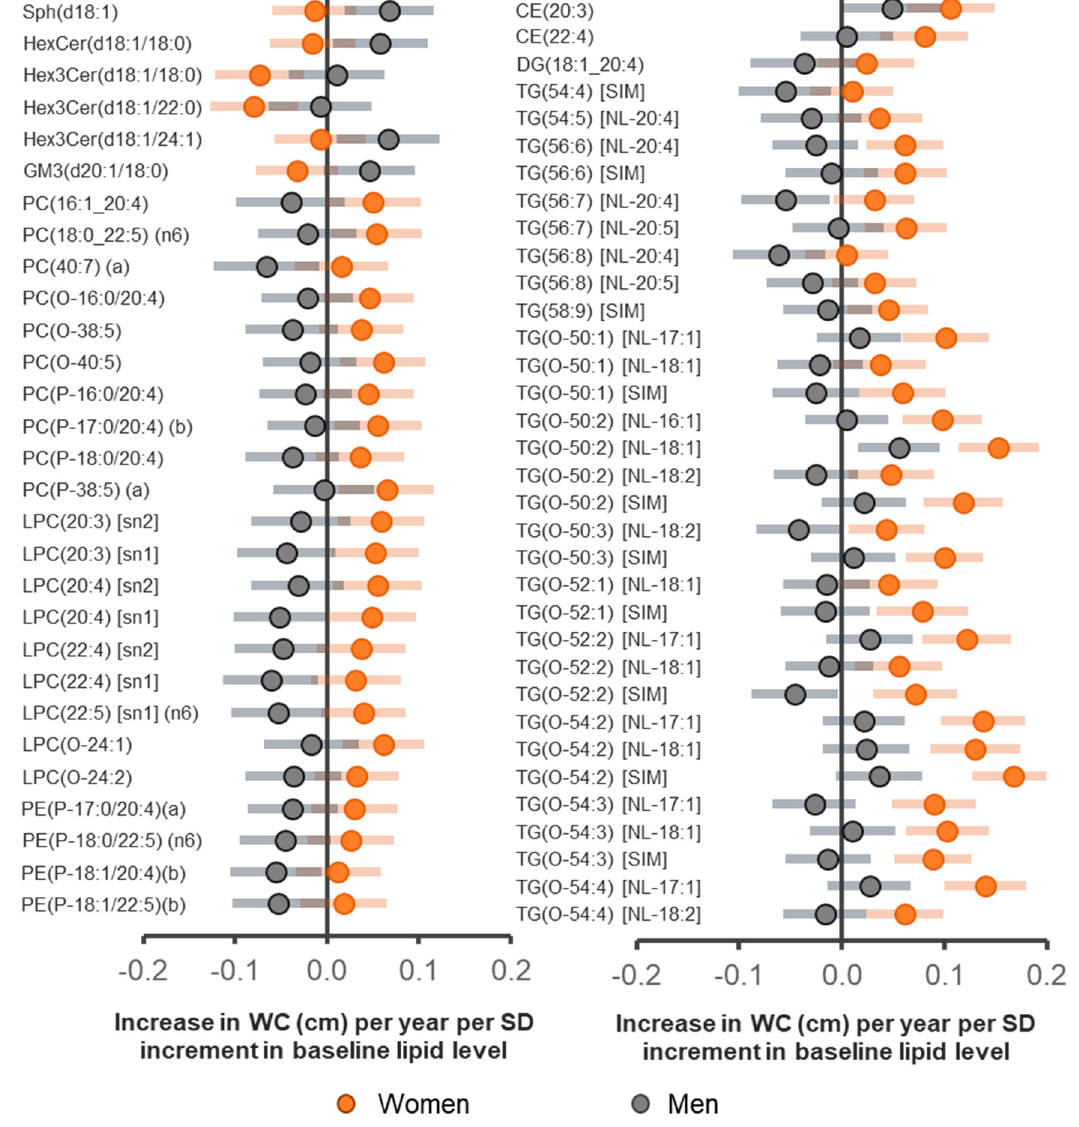
Figure 4. The interaction of sex in the associations of lipid species with change in WC. Linear regression analyses of lipid species with change in WC were performed in models adjusting for age, sex, baseline WC, cholesterol, HDL-C, triglycerides, smoking, education, physical exercise time and TV viewing time including an interaction term for sex. The change in WC (an outcome) was annualized and each lipid (a predictor) was scaled to unit SD prior analysis. The β - coefficients for each sex where the associations with change in WC showed a significant interaction (interaction p < 0.05) are plotted. Gray circles (for men) and orange (for women) represent 1 cm increase in WC per year per SD increase in the lipid predictor. Error bars show 95% confidence